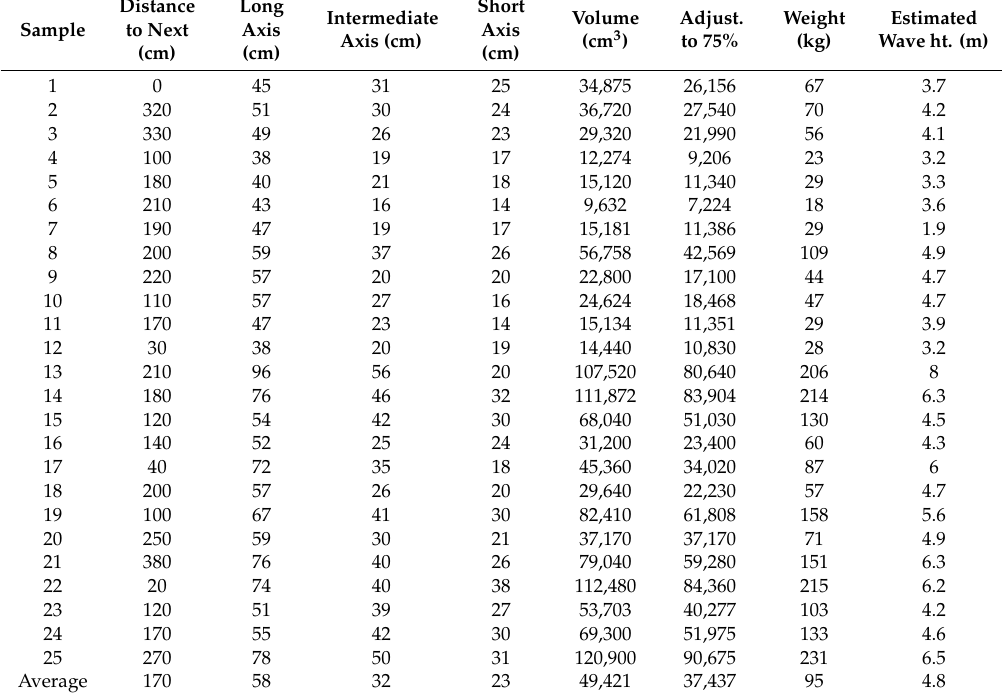
Table 4. Quantification of boulder size, volume and estimated weight from coastal bar samples through Transect 1d (continuation from 1c east of El China). The laboratory result for density at 2.55 gm / cm 3 is applied uniformly in order to calculate wave height for each